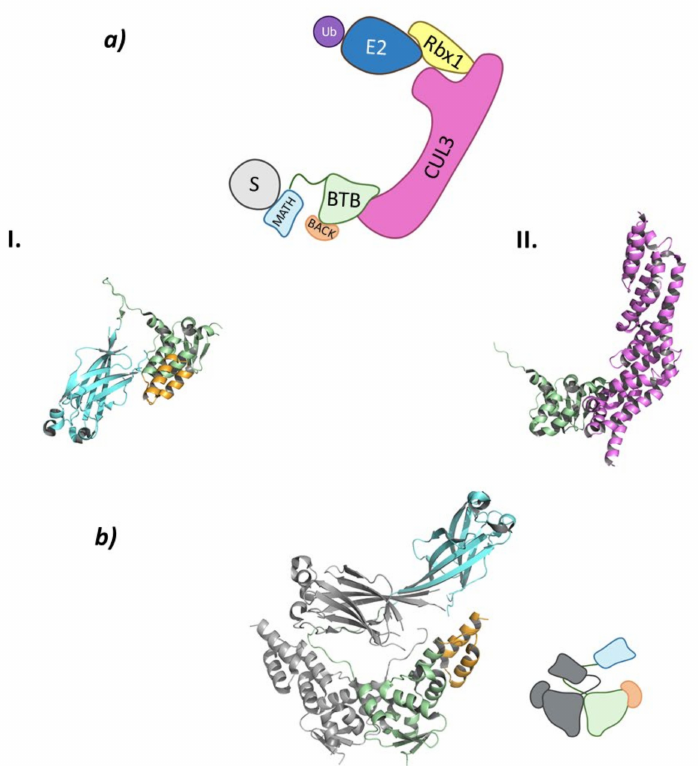
Figure 7. Cul3 SPOP ( a ) Schematic representation of the assembly of the Cul3-SPOP E3 ligase: ubiquitin (Ub) in purple, E2 ligase (E2) in dark blue, Ring Box Protein 1 (Rbx1) in yellow, Cullin-3 (Cul3) in magenta, substrate protein (S) in grey, and adaptor protein SPOP shown as the three domains: MATH in light blue, BTB in green, and BACK in orange. Protein assembly I is the PyMOL cartoon representation of the three domains that make up SPOP as found in PDB code 3HDI. Protein assembly II is the 3D representation of the fragment of Cul3 bound to the BTB domain as found in PDB code 4EOZ. ( b ) 3D representation of the dimerization of SPOP as found in PDB code